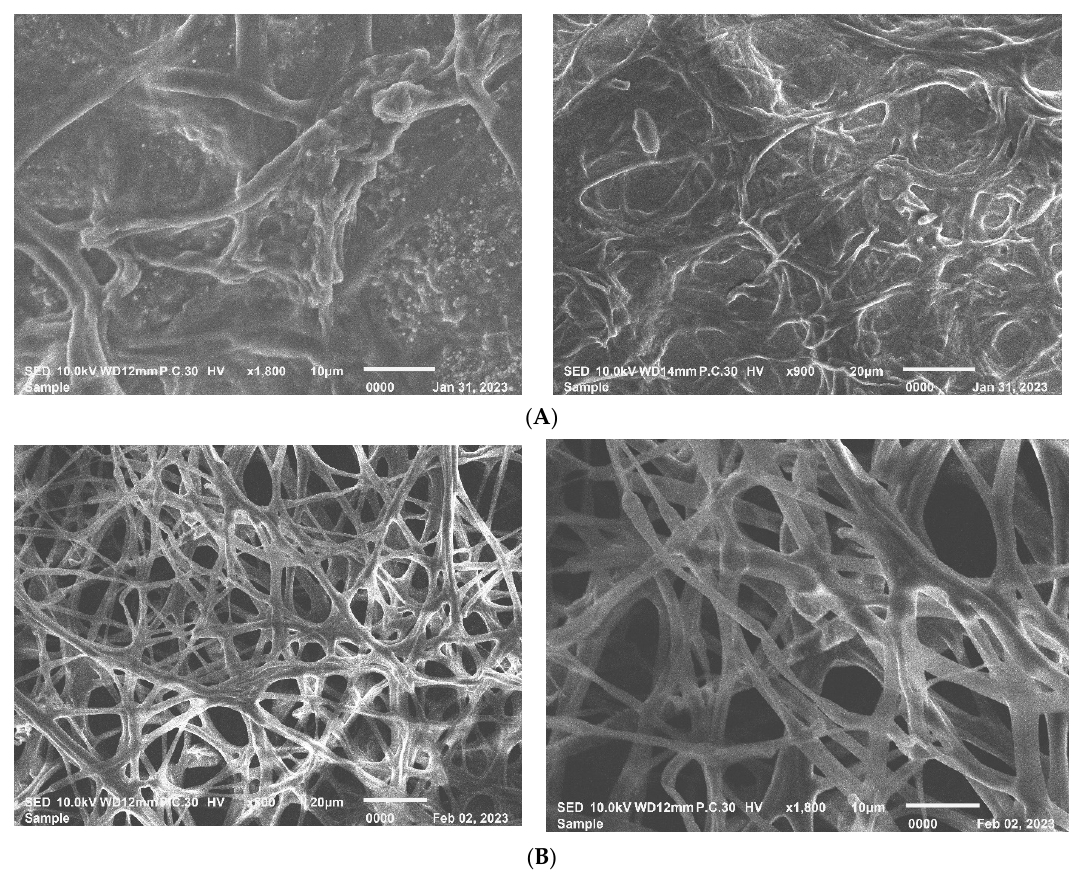
Figure 5. Scanning electron microscope (SEM) images of mycel of Alternaria alternata grown on PDA for 7 days after incubation, where ( A ) is influenced by Nano-Se (100 ppm) and ( B ) is the negative control with no treatment. ( A ) Mycelial growth of Alternaria alternata influenced by nano-Se application at 100 ppm. ( B ) Normal mycelial growth of Alternaria alternata without nano-Se application (Control).